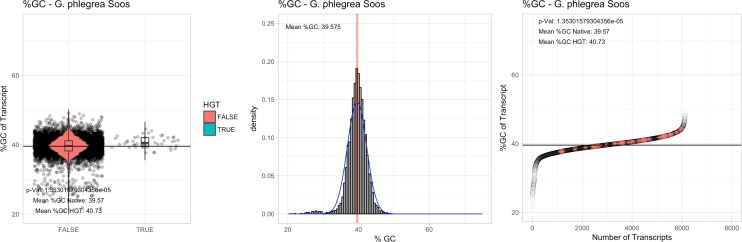
%GC – Galdieria phlegrea Soos: (Left) Violin plot showing the %GC distribution across native transcripts and HGT candidates.(Mid) Cumulative %GC distribution of transcripts. Red line shows the average, blue line a normal distribution based on the average value. (Right) Ranking all transcripts based upon their %GC content. Red ‘*' demarks HGT candidates. As the %GC content was normally distributed, students test was applied for the determination of significant differences between the native gene and the HGT candidate subset.